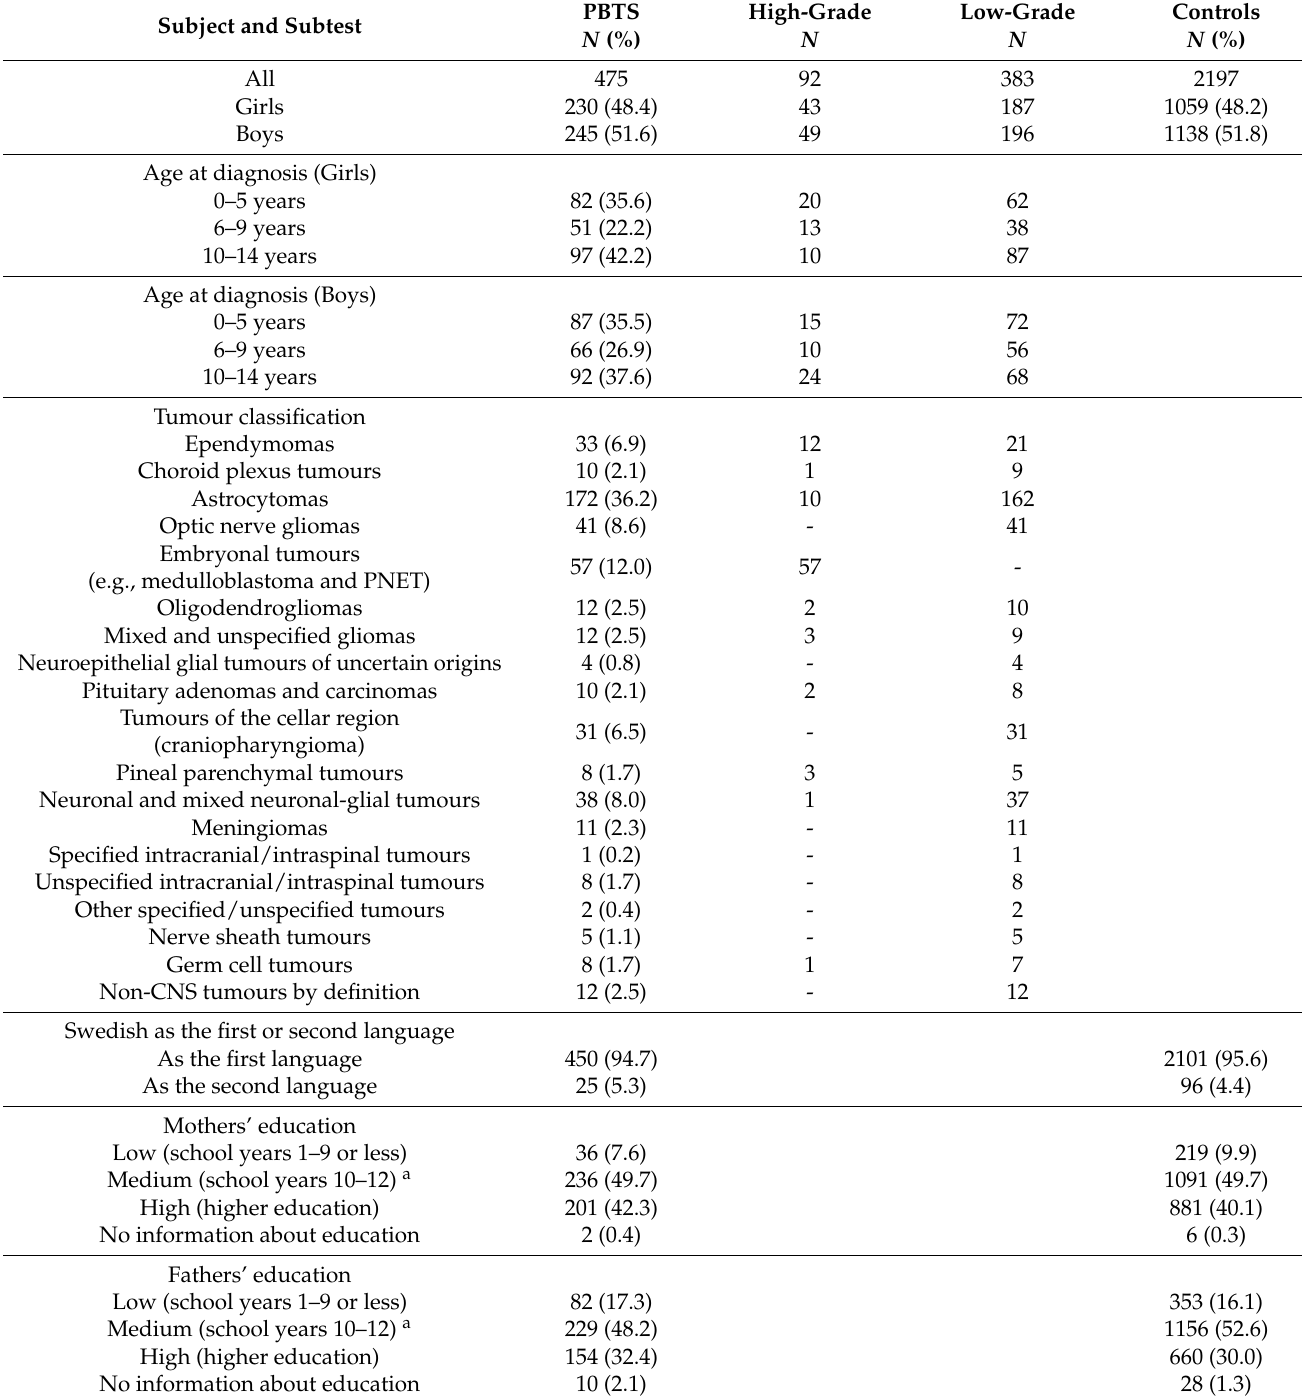
Table 1. Characteristics of the included paediatric brain tumour survivors (PBTS) ( n = 475) and controls ( n = 2197), including tumour classification as reported in the Swedish Childhood Cancer Registry. CNS: central nervous